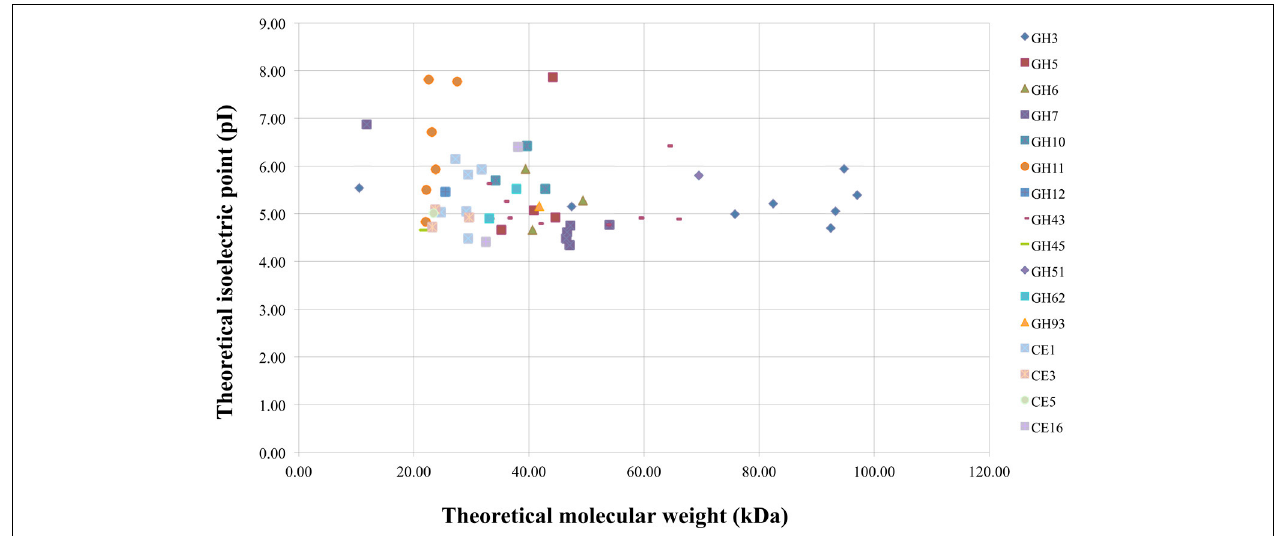
FIGURE 5 | Theoretical molecular weight of secreted enzymes of M. thermophila classified in several GHs and CEs families, plotted against theoretical pI. The average molecular weight was calculated at 51.05 ±